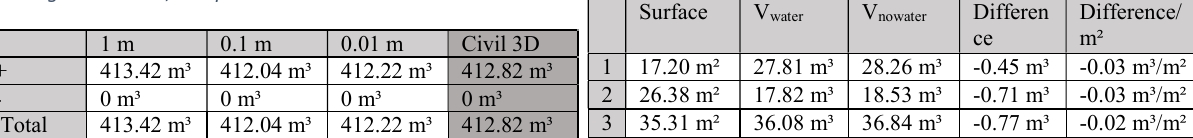
Table 2: Volume of the section of Gentbrugge testcase with the different grid cell sizes, compared to Civil 3D.